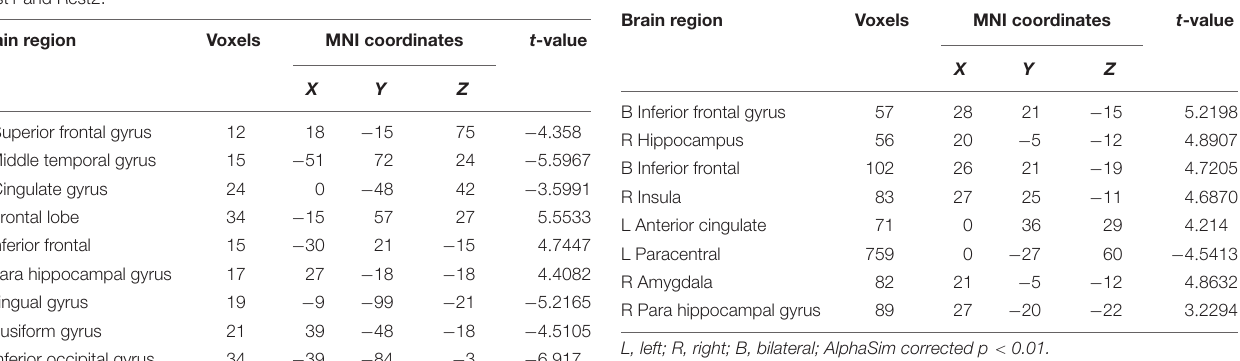
TABLE 3 | Brain regions of the FG where the ReHo map differed between the Rest1 and Rest2. Brain region Voxels MNI coordinates